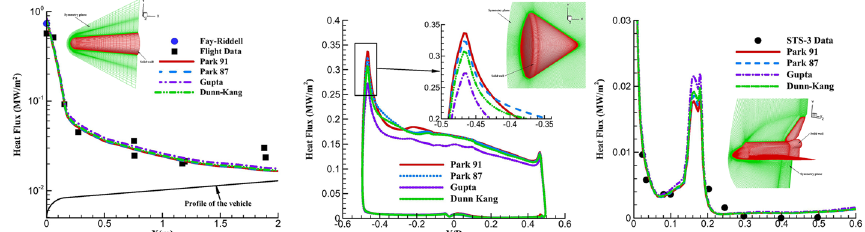
Fig. 7 Heat flux distributions of ELECTRE, Apollo, and Space Shuttle Orbiter with different chemical reaction models [83]